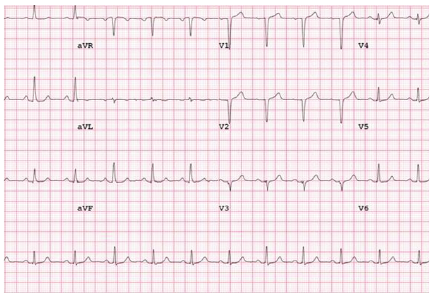
Figure 1: Baseline electrocardiogram demonstrating normal base- line conduction.